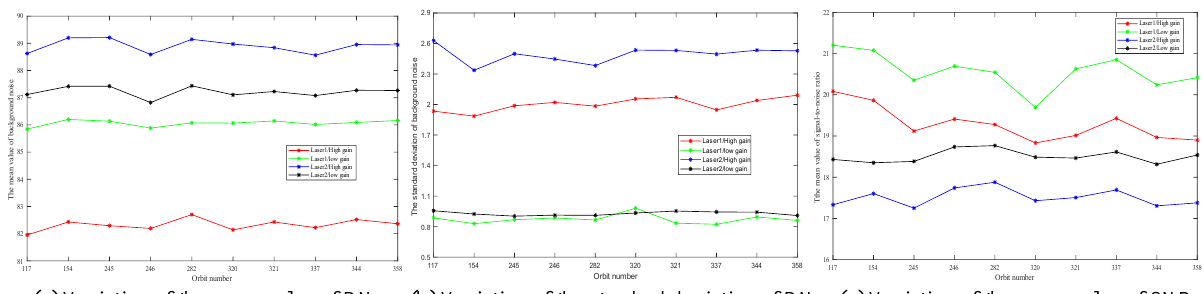
(a) Variation of the mean value of BN (b) Variation of the standard deviation of BN (c) Variation of the mean value of